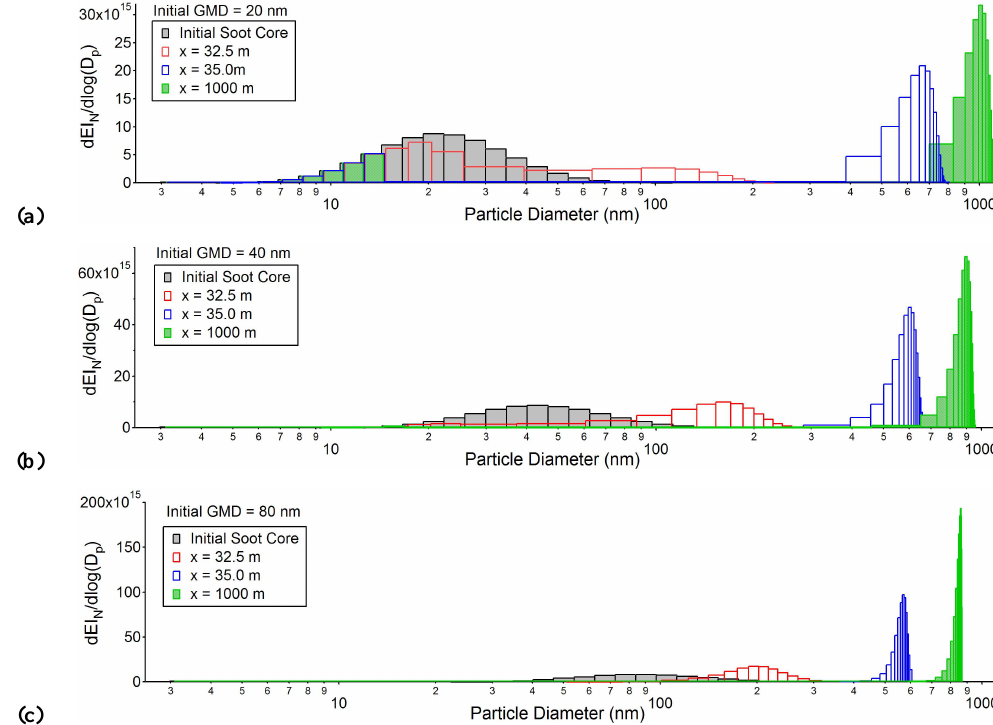
Fig. 8. Effects of initial soot core size on size distributions of ice coated soot particles as a function of downstream distance ( x ) when geometric mean diameter (GMD) of initial particle size distribution of soot cores is: (a) 20nm; (b) 40nm; (c)